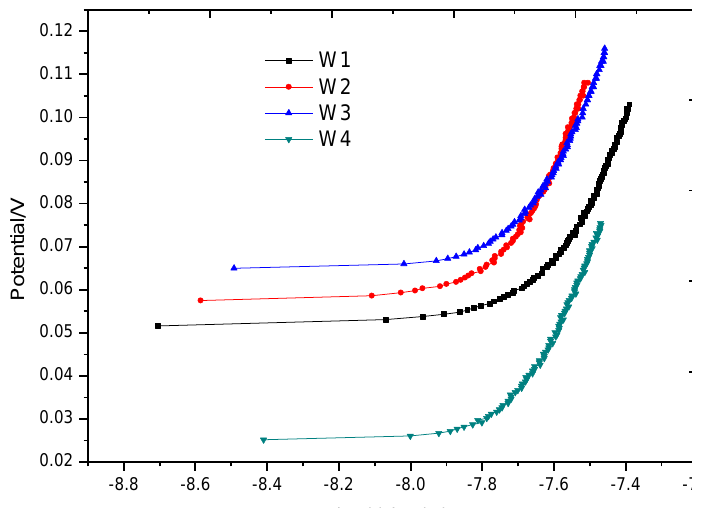
Figure 13. Anodic polarization curve for each monitoring point after first drying process.